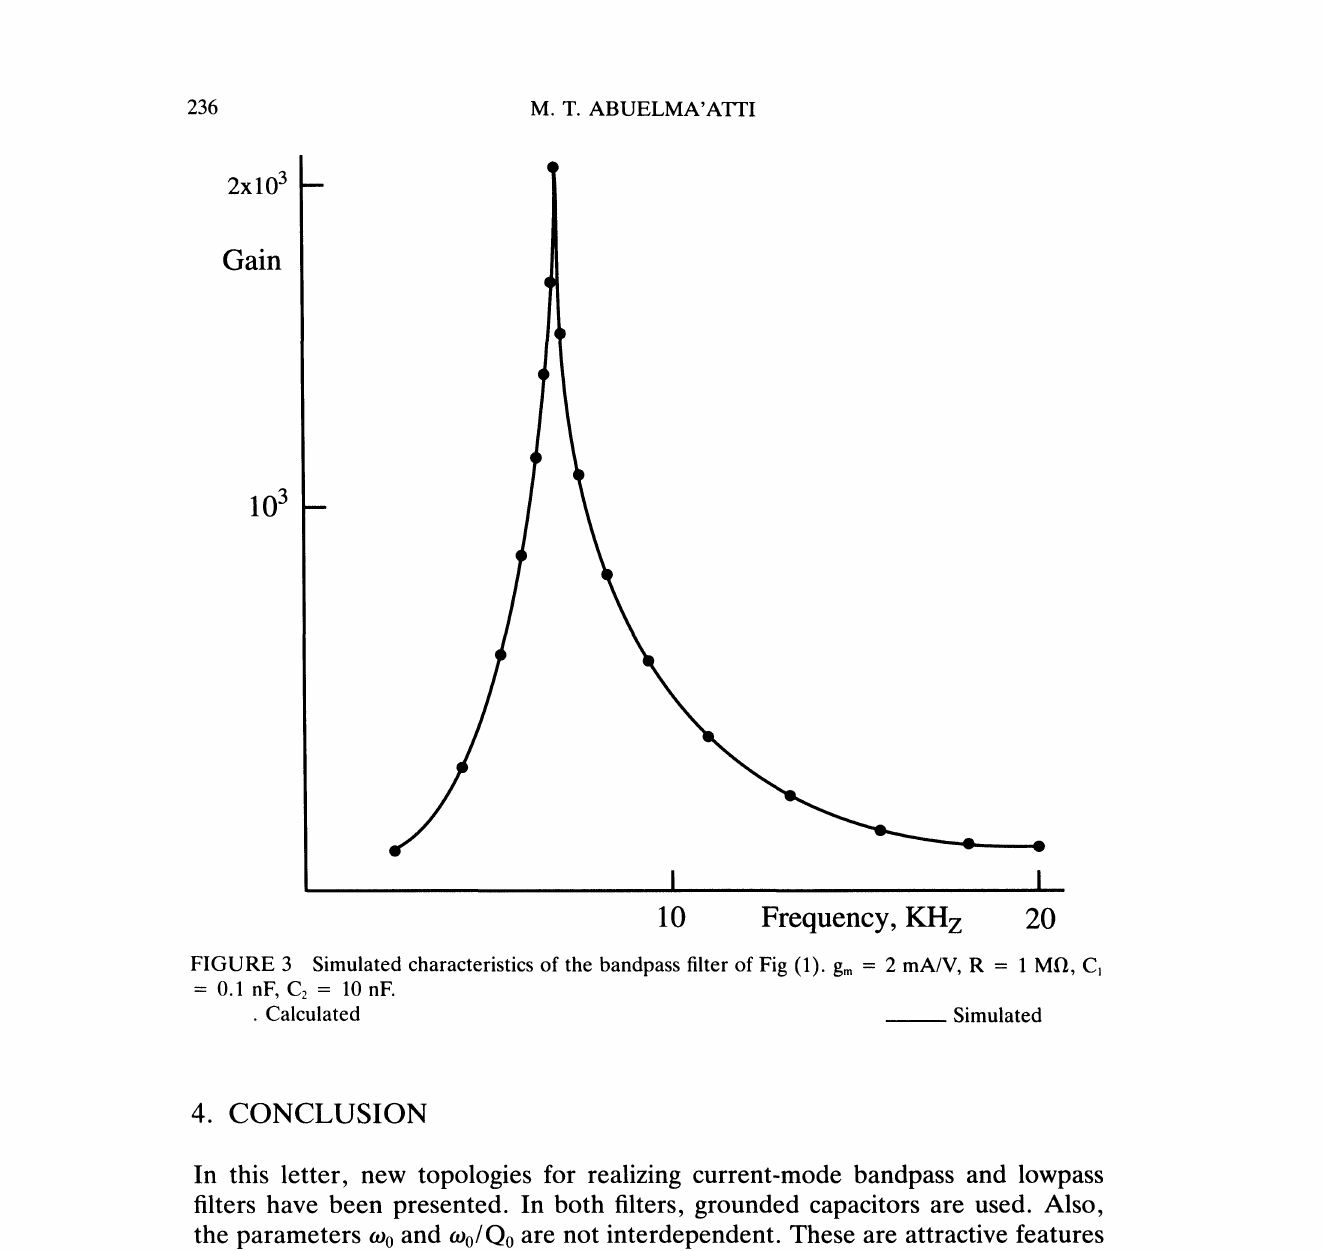
FIGURE 3 Simulated characteristics of the bandpass filter of Fig (1). gm 2 mA/V, R M[I, C 0.1 nF, C2 10nF. Calculated